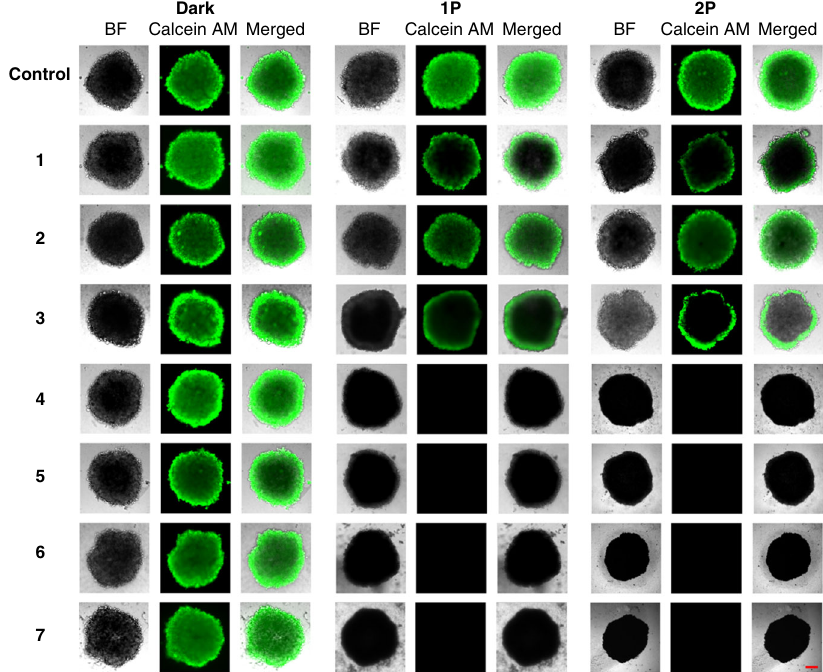
Fig. 4 Representative image of the cell viability assay in HeLa MCTS. MCTS were treated with compounds 1 – 7 (20 μ M, 2% DMSO, v %) in the dark for 3 days. After this time, MCTS were kept in the dark, exposed to 1P irradiation (500 nm, 16.7 min, 10.0 mW cm − 2 , and 10 J cm − 2 ) or 2P irradiation (800 nm, 10 J cm − 2 , and section interval of 5 μ m). After 2 days, the cell viability was assessed by measurement of the fl uorescence of calcein ( λ ex = 495nm, λ em = 515 nm), which is generated in living cells from Calcein AM. The scale bar represents a length of 200 µ